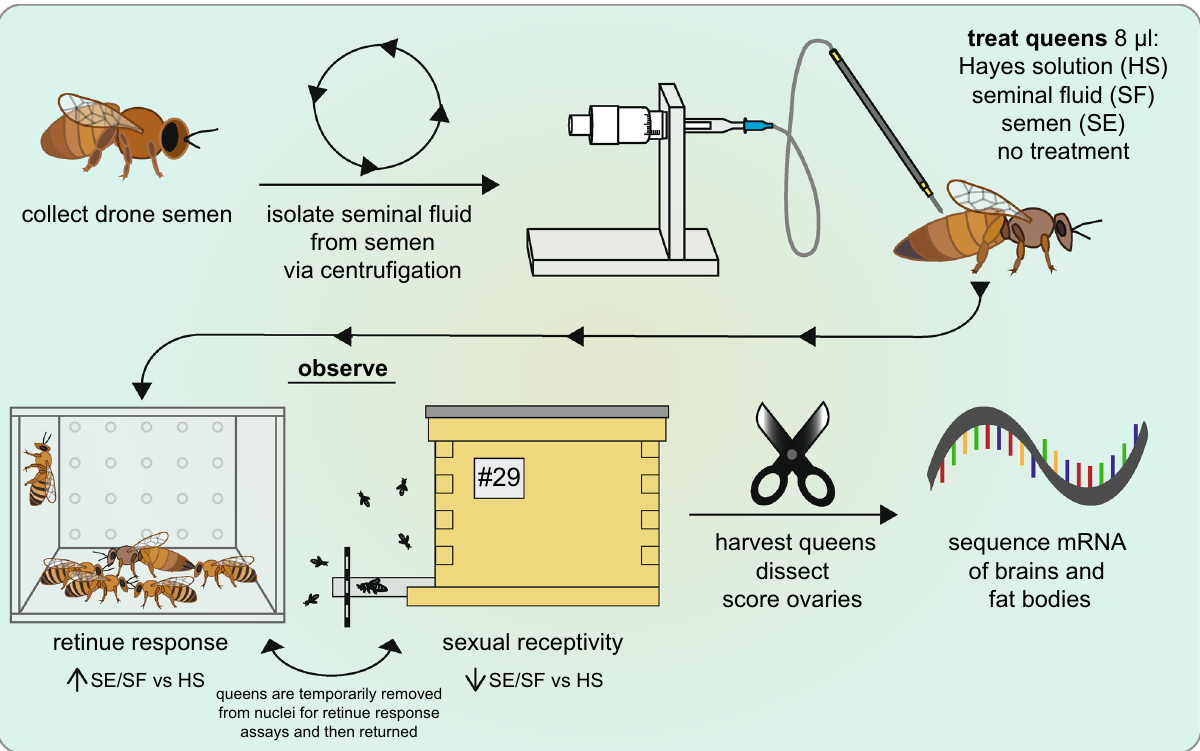
Figure 1. Procedure for queen experiments. Semen was first collected from ~ 300 drones. In order to isolate seminal fluid from semen, semen was centrifuged to pellet sperm. The seminal fluid-containing supernatant was then collected. Queens were injected between the second and third abdominal tergite with 8 µL Hayes solution (the semen diluent used), seminal fluid, or semen. A subset was left untreated (virgins). Queens were observed for mating flight attempts in small mating nuclei as an assay for sexual receptivity. A subset of those queens was taken from the mating nuclei and placed into a Plexiglass container where the number and frequency of workers performing retinue response to the queen were recorded. After the observation period ended, queens were harvested and dissected. Ovaries were scored for development and fat bodies and brains were collected for RNA extraction and RNAseq analysis. Parts of the figure were adapted with permission from Brutscher et al., Insects, 2019 under the Creative Commons Attribution 4.0 International Public License (https ://creat iveco mmons .org/ licen ses/by/4.0/legal